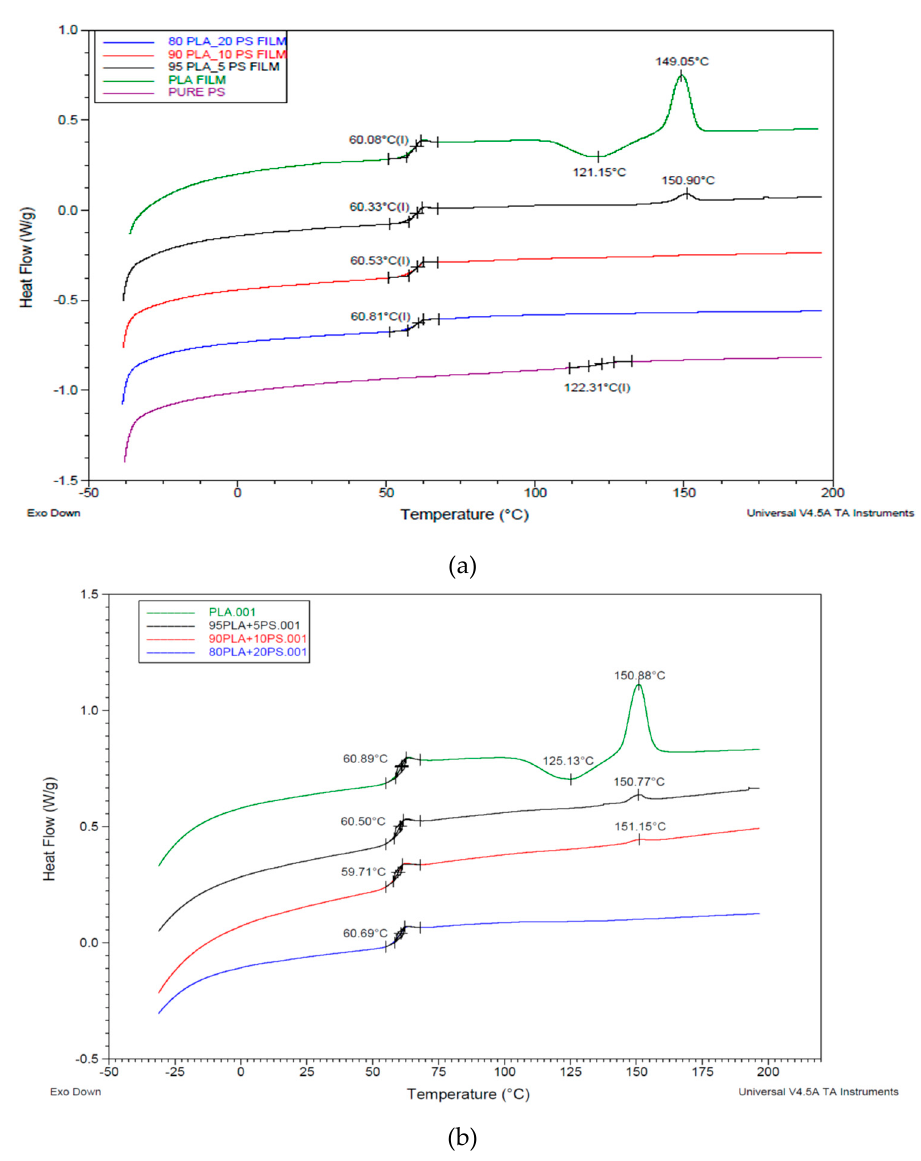
Figure 4. Comparison between the second heating thermograms of the ( a ) PLA/acrylic copolymer-based product (PS) cast films; ( b ) PLA/PS cast films treated for 2 min at 190 °C. Exothermal peaks are directed down.